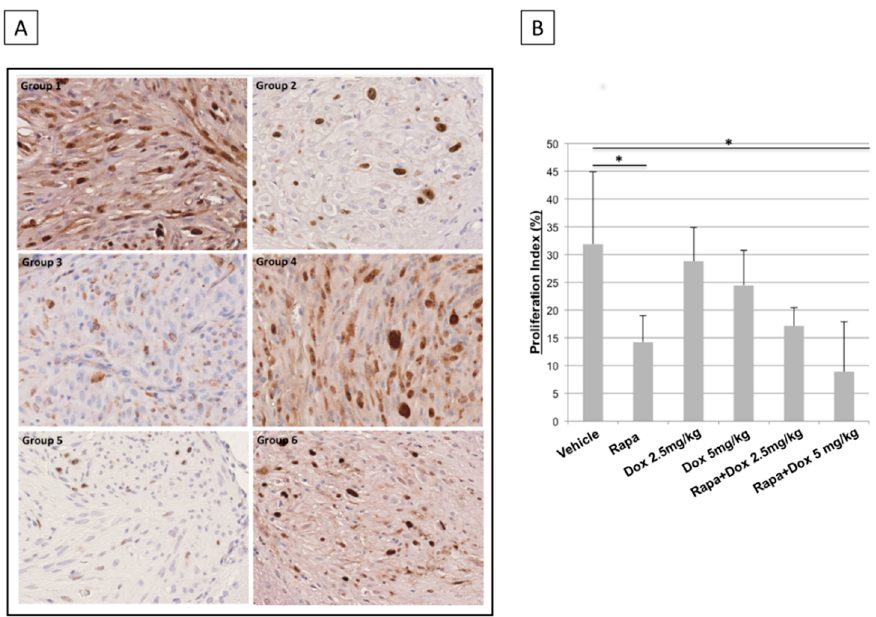
Figure 5. Immunohistochemical evaluation of therapies on glioma proliferation ( A ) Representative images of Ki67-immunoreactivity showed by tumor samples from each groups. Formalin-fixed, Wax-embedded, anti-Ki67 IHC stained slides—Final Magnification 400 × ; ( B ) Proliferation index comparison between vehicle group vs. treated groups; statistical analysis was performed through the unpaired Mann–Whitney U-test and ANOVA with Tukey correction (* p < 0.05).